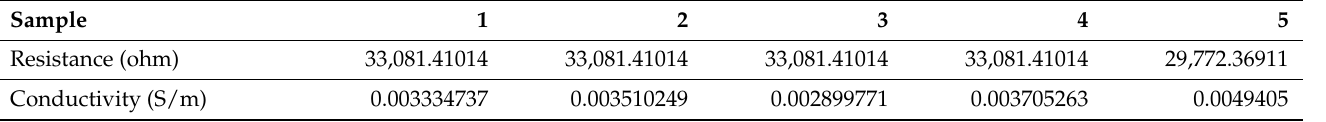
Table A5. Conductivity Data for Nylon 610 Nanocomposites with 4.5 wt% Graphite Nanosheets Treated at 200 ◦ C and − 1 bar.